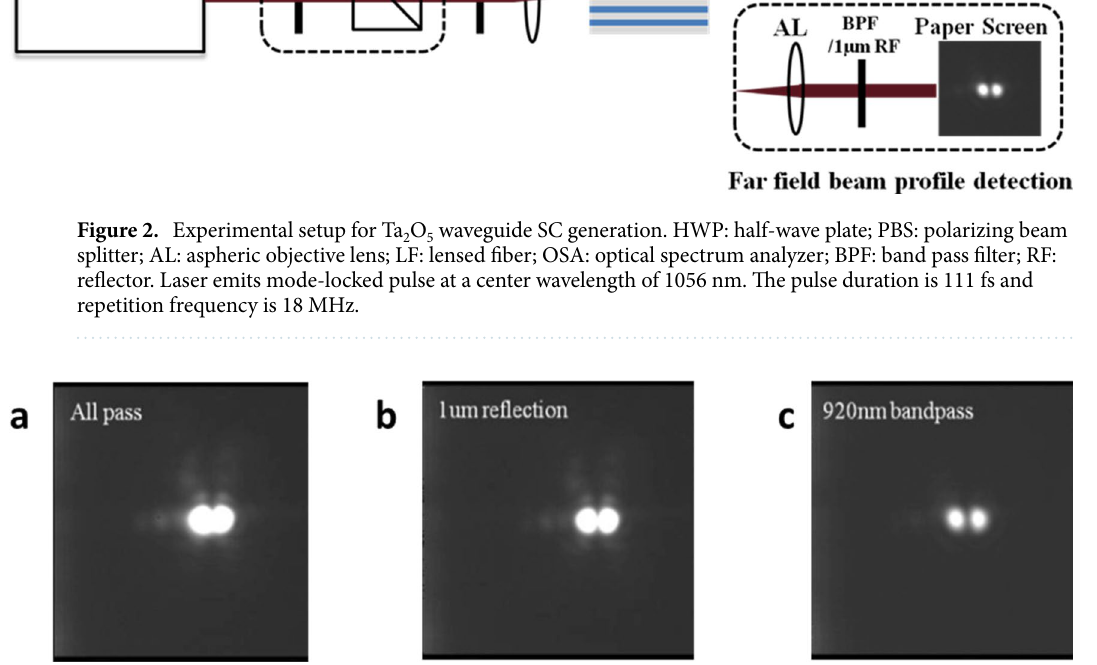
Figure 3. ( a–c ) Distribution of high-order modes without any filter, through a 1 µm reflector and 920 nm band-pass